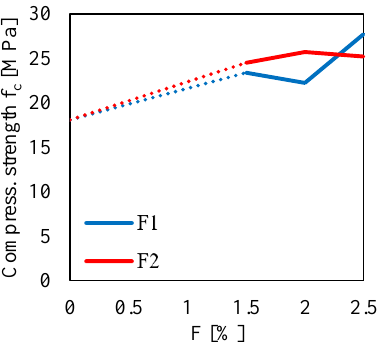
Figure 11. Compressive strength f c measured in the CTs for two fiber type (F1 and F2) with different fiber